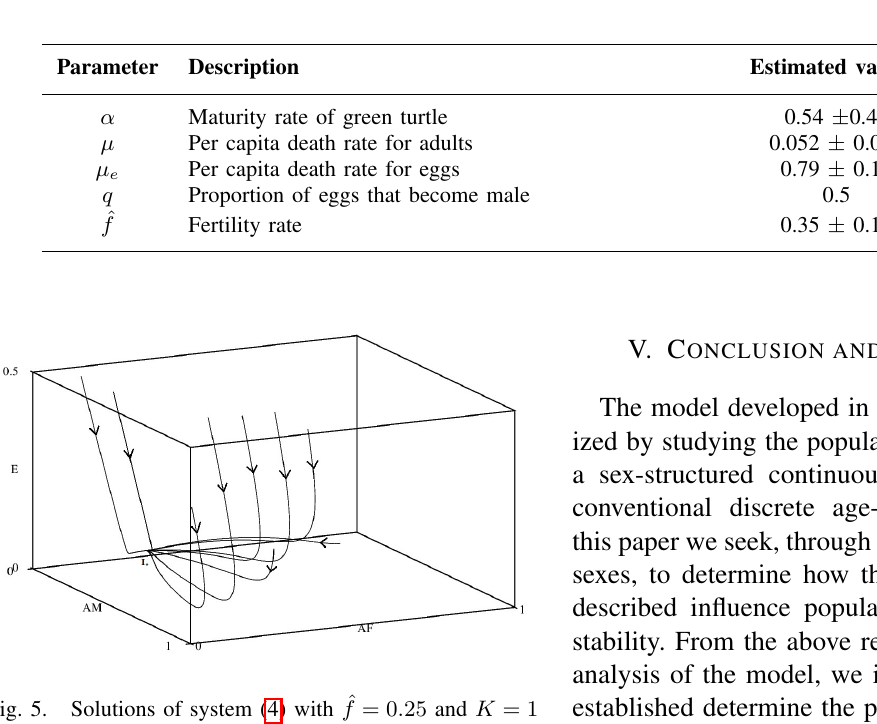
P ARAMETERS DESCRIPTION AND VALUES CONSIDERING THE G ALAPAGOS I SLANDS AND E CUATORIAN MAINLAND GREEN SEA TURTLE POPULATIONS .